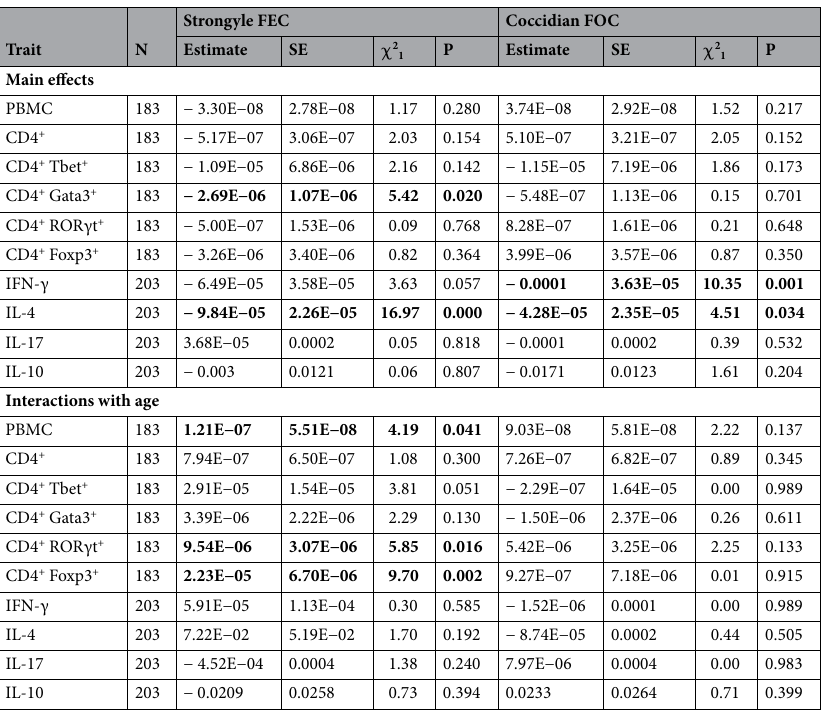
Table 1. Results of generalised linear model analysis of associations between either strongyle faecal egg count (FEC) or coccidian faecal oocyst count (FOC) and each of our immunological parameters. Estimates and test statistics are shown for models where only the variable indicted with included in the model; interaction estimates show difference in slope between lambs and adults. Associations significant at α = 0.05 are highlighted in bold. Statistical significant values are in